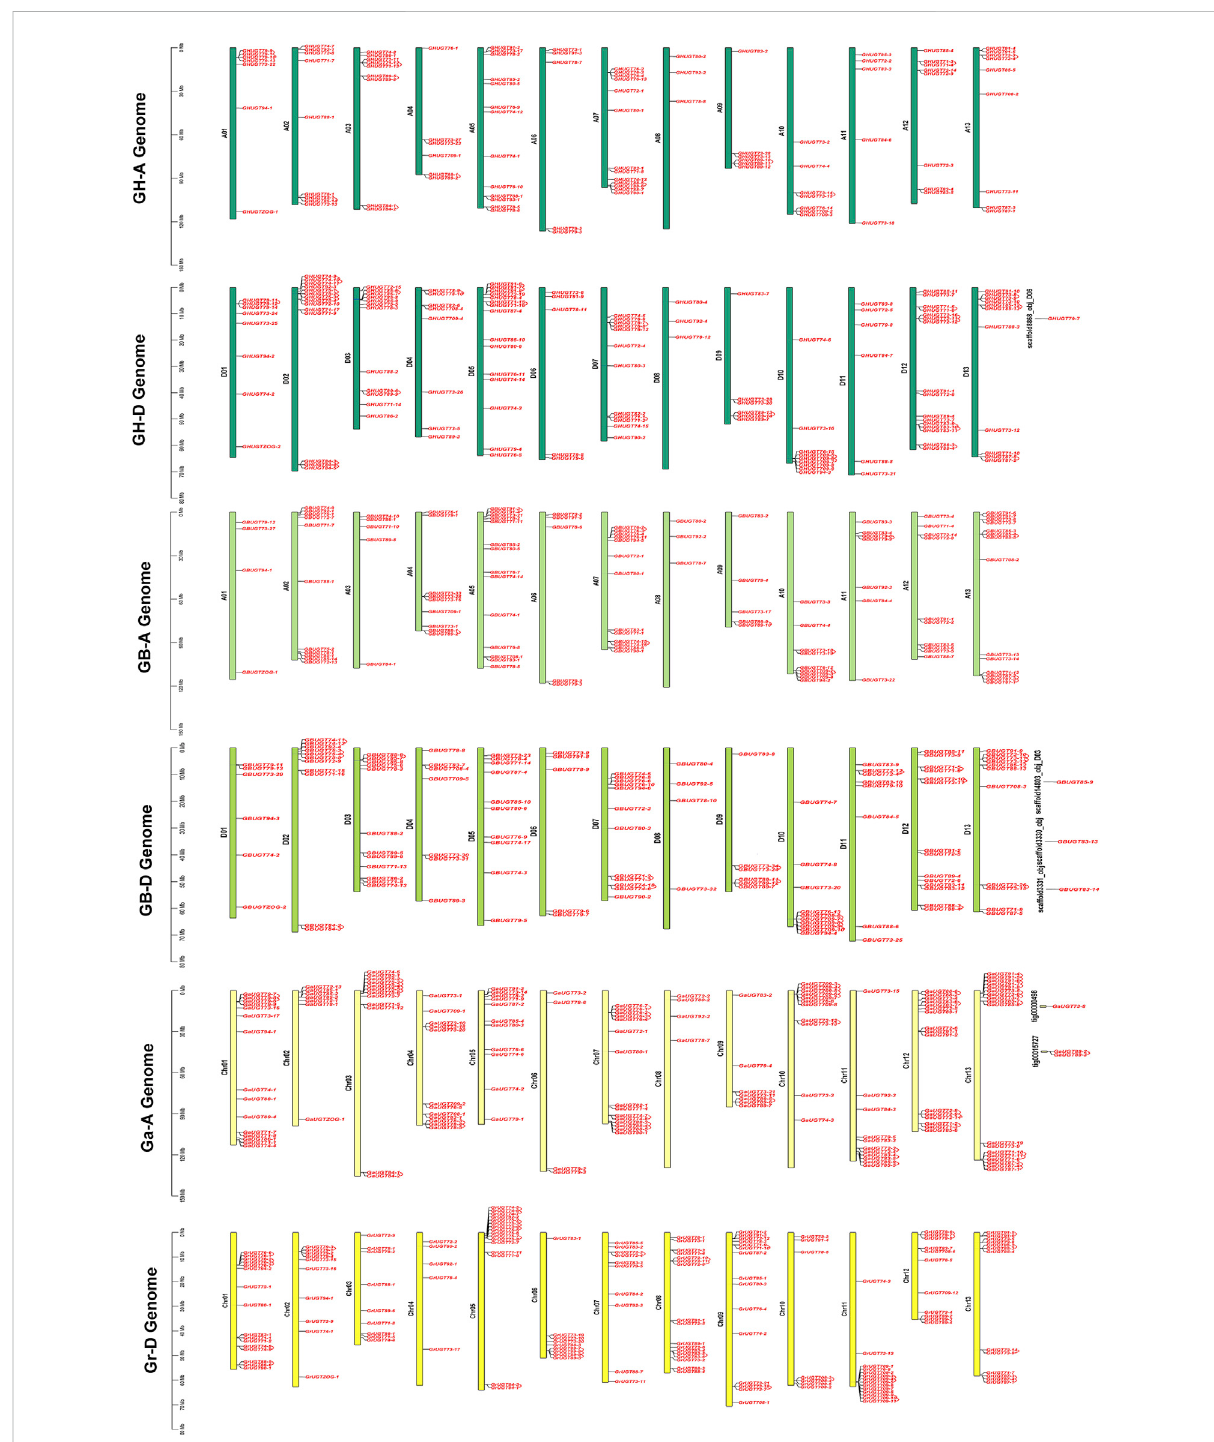
FIGURE 3 Location of UGTs in four cotton species. Gene pairs have been annotated on the chromosome with gene ID. The vertical bars represent the location of UGTs and the length of